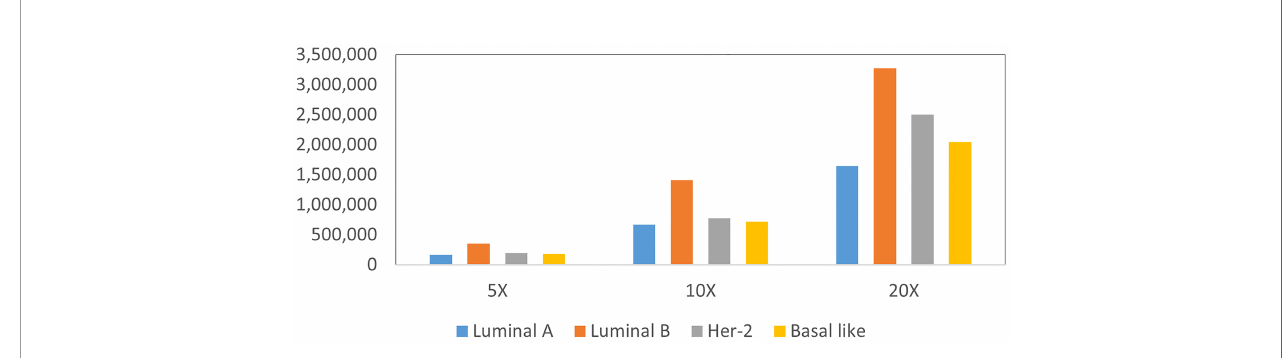
FIGURE 4 | Statistics patches of different molecular subtypes at each